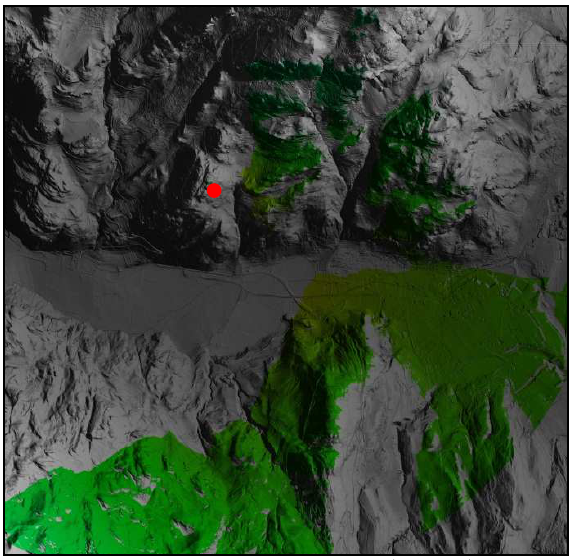
Figure 11. Visibility map: the portion (in green) of the surrounding territory that can be controlled by one of the artillery spot (red) of the Nagià Grom